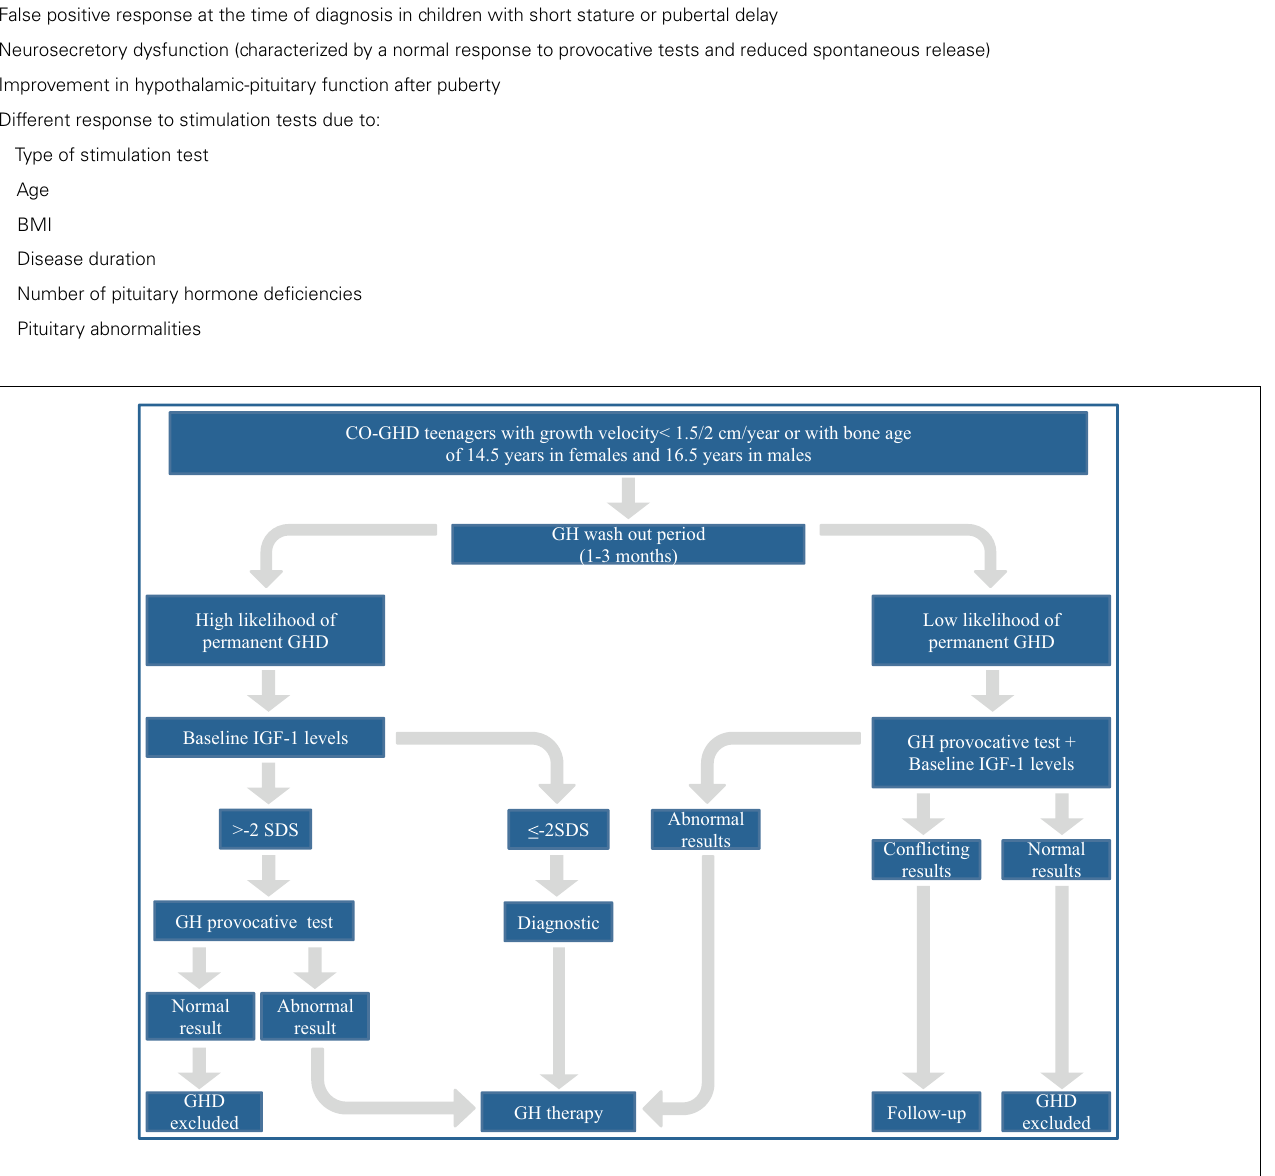
FIGURE 1 |The proposed workup for assessing transition patients with growth hormone deficiency. From a consensus statement issued by the European Society for Pediatric Endocrinology (Clayton et al.,